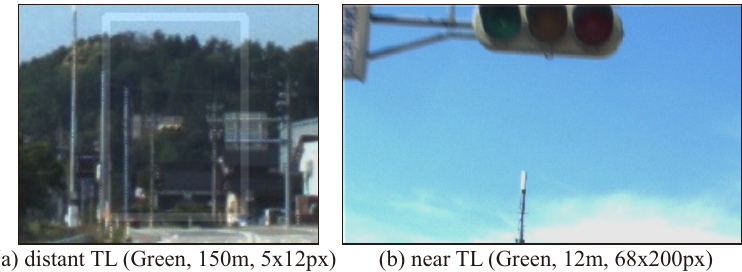
Figure 19. Typical improvement for far arrow TLs.